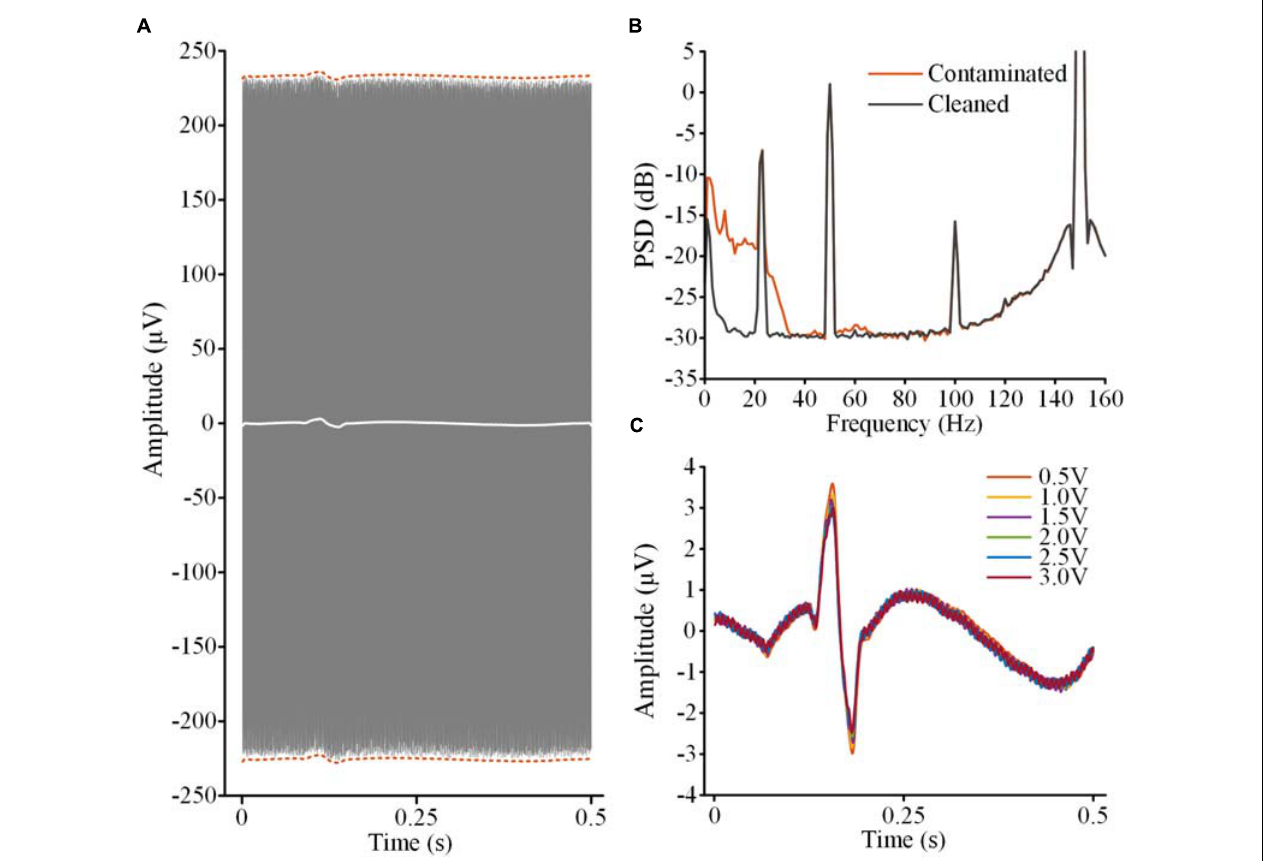
FIGURE 8 | ECG artifact removal without extra filtering of DBS artifacts. (A) The gray lines are the overlapped contaminated LFPs aligned according to the R-waves detected in the monopolar channel. The dashed red lines indicate the envelope of the ECG artifacts. The white line is the averaged waveform of the aligned recordings. (B) PSDs of the contaminated LFP and ECG-cleaned LFP. (C) The templates of the ECG artifacts in the contaminated LFPs with different DBS amplitudes.